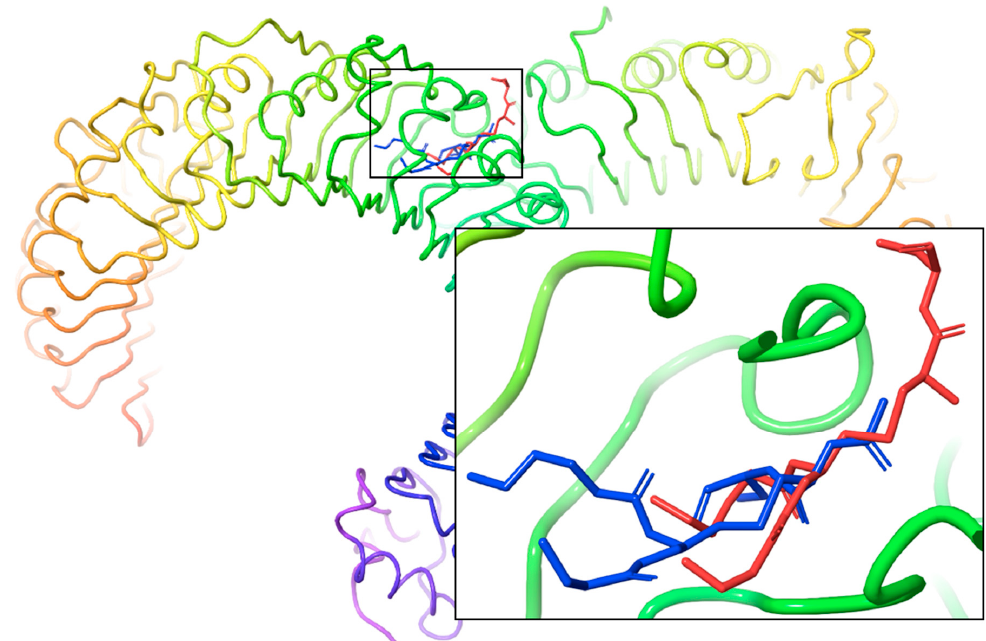
Figure 3. Comparison of the best flexible docking result (lowest docking score) of N -acetyl Cap2Cys (in blue) with the original conformation of the Cap2Cys (in red). Ligands are inserted into the binding pocket from up right to bottom left. The N -acetyl Cap2Cys is much more embedded into the binding pocket comparing to the position of Cap2Cys.